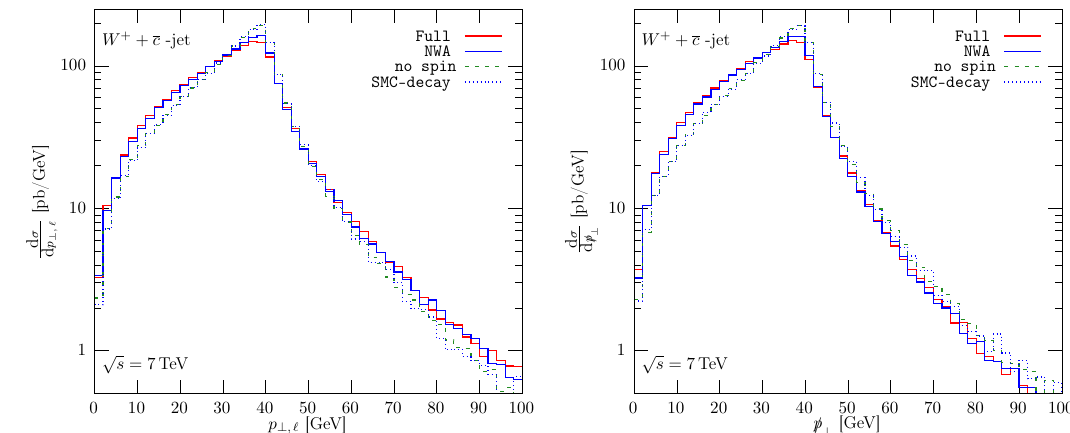
Figure 2 . Distributions for fully inclusive W + + ¯ c production in the leptonic channel as a function of the tranverse momentum of the charged lepton (left panel) and of the missing p T (right panel), as obtained from LHEs. Results are based on the ABMP16_3_NLO PDF set and on the scale choice is µ = µ R = µ F = H T / 2